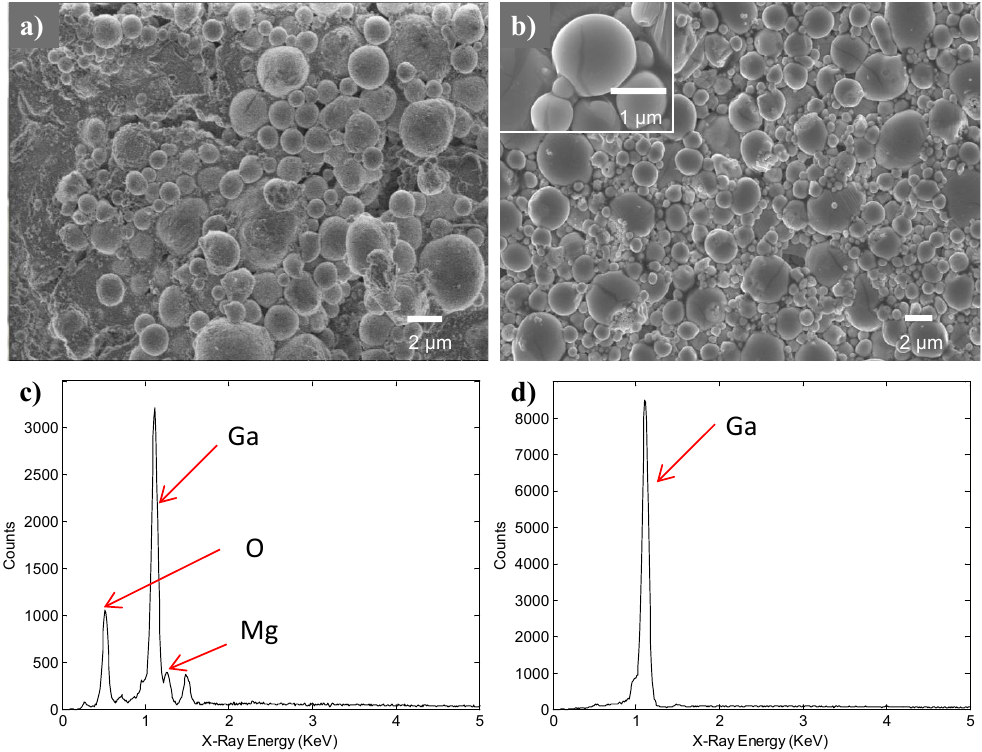
Figure 1. Stability of gallium-IPA dispersion before (( a ) and ( c ), labeled as RT for room temperature) and after ( b ) and ( d ) being quenched by dry ice. The status of samples at 0, 1 and 2 h after sonication is shown. The stability can be judged by whether precipitate is formed on the bottom ( a ) and ( b ) and whether the side view turns clear ( c ) and ( d ).